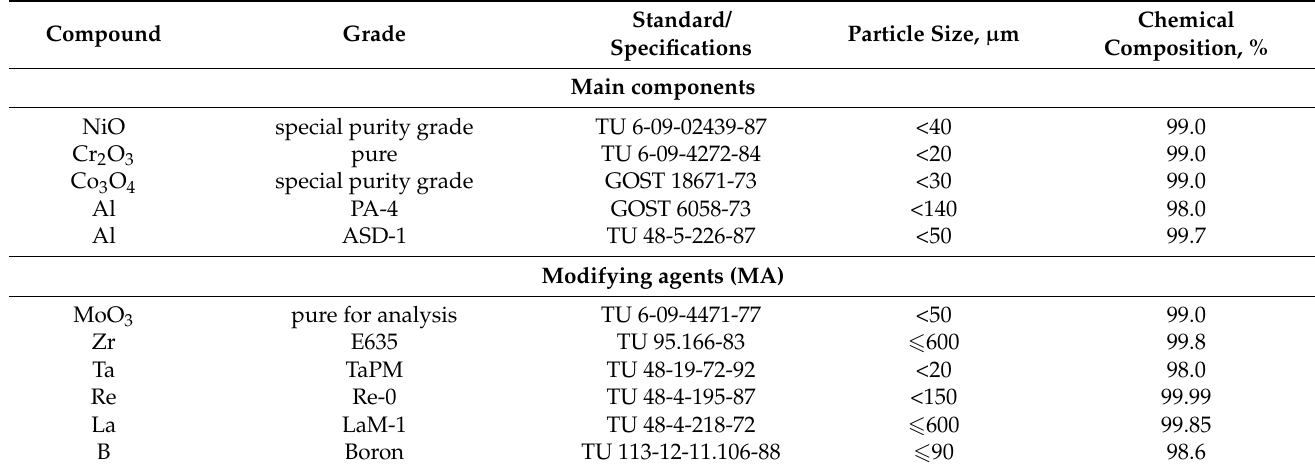
Table 1. The characteristics of the initial compounds and modifying agents.